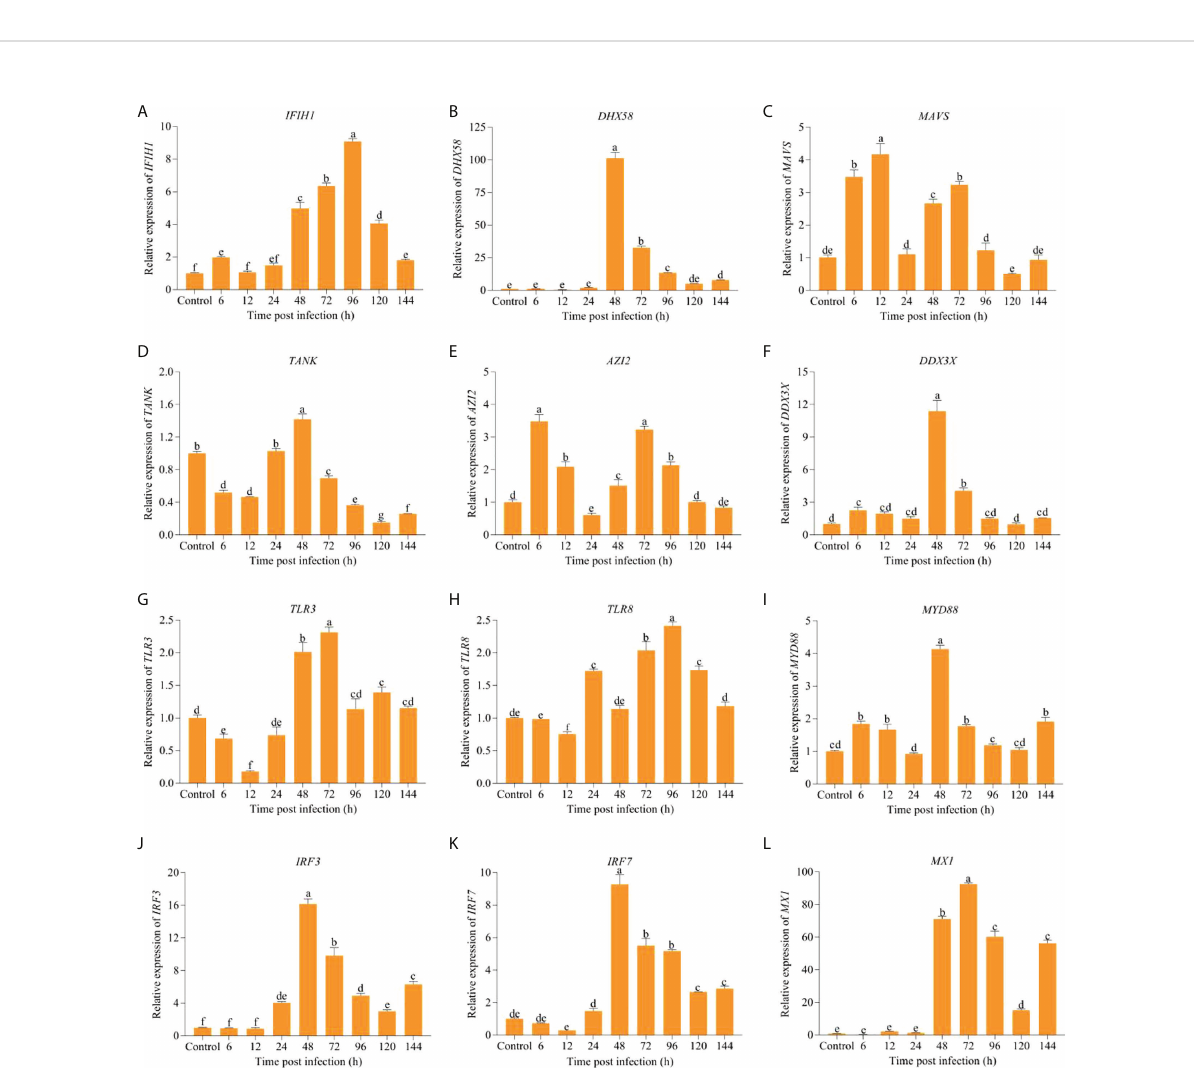
FIGURE 7 The changes in expression levels of key immune-related DEGs involved in RLR and TLR signaling pathways over different periods after IHNV challenge. (A) IFIH1 ( MDA5 ). (B) DHX58 ( LGP2 ). (C) MAVS ( IPS-1 ). (D) TANK . (E) AZI2 ( NAP1 ). (F) DDX3X . (G) TLR3 . (H) TLR8 . (I) MYD88 . (J) IRF3 . (K) IRF7 . (L) MX1 . The different lowercase letters above the bars indicate signi fi cant differences ( P <